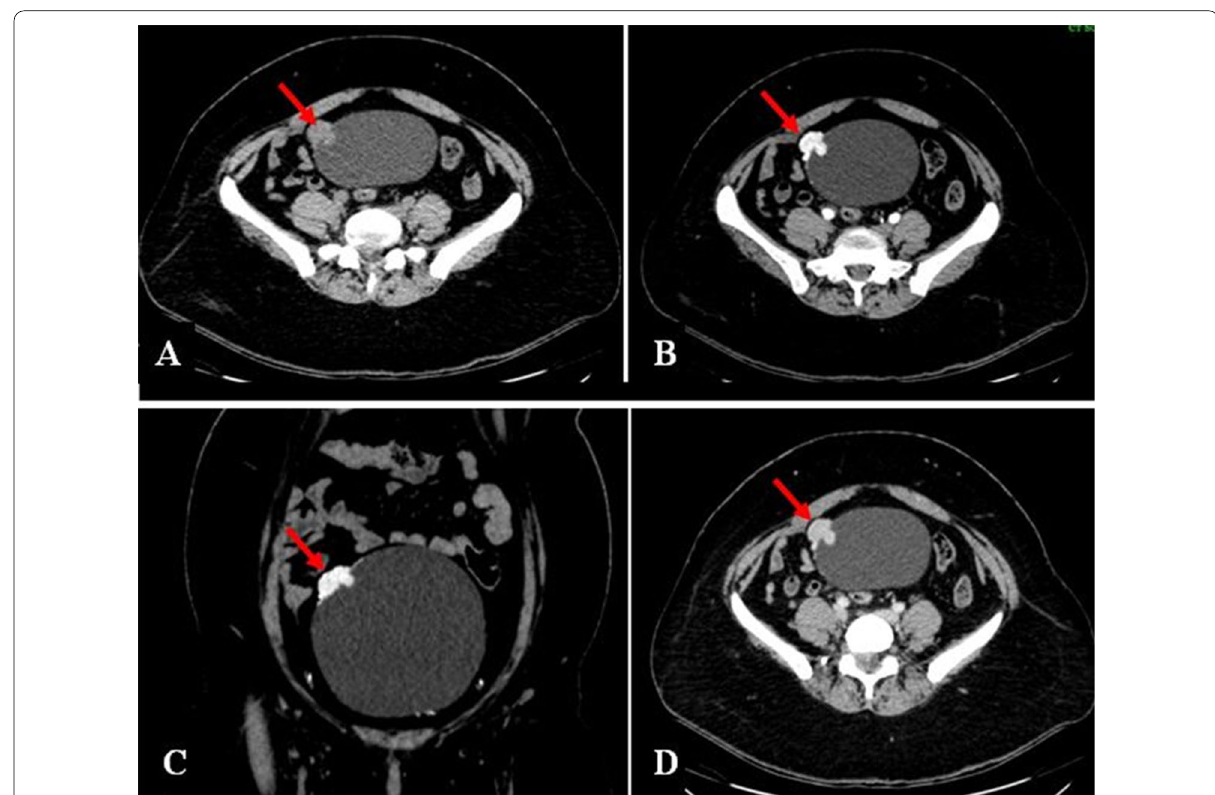
Fig. 2 A Non-contrast CT reveals exo-endophytic lobulated mass lesion (arrow) in the right lateral aspect of the dome of the urinary bladder. CECT abdomen arterial phase axial ( B ) and coronal reformatted ( C ) images show intense arterial enhancement of the lesion (arrow). Venous phase axial ( D ) images show persistent enhancement (arrow) with absent washout